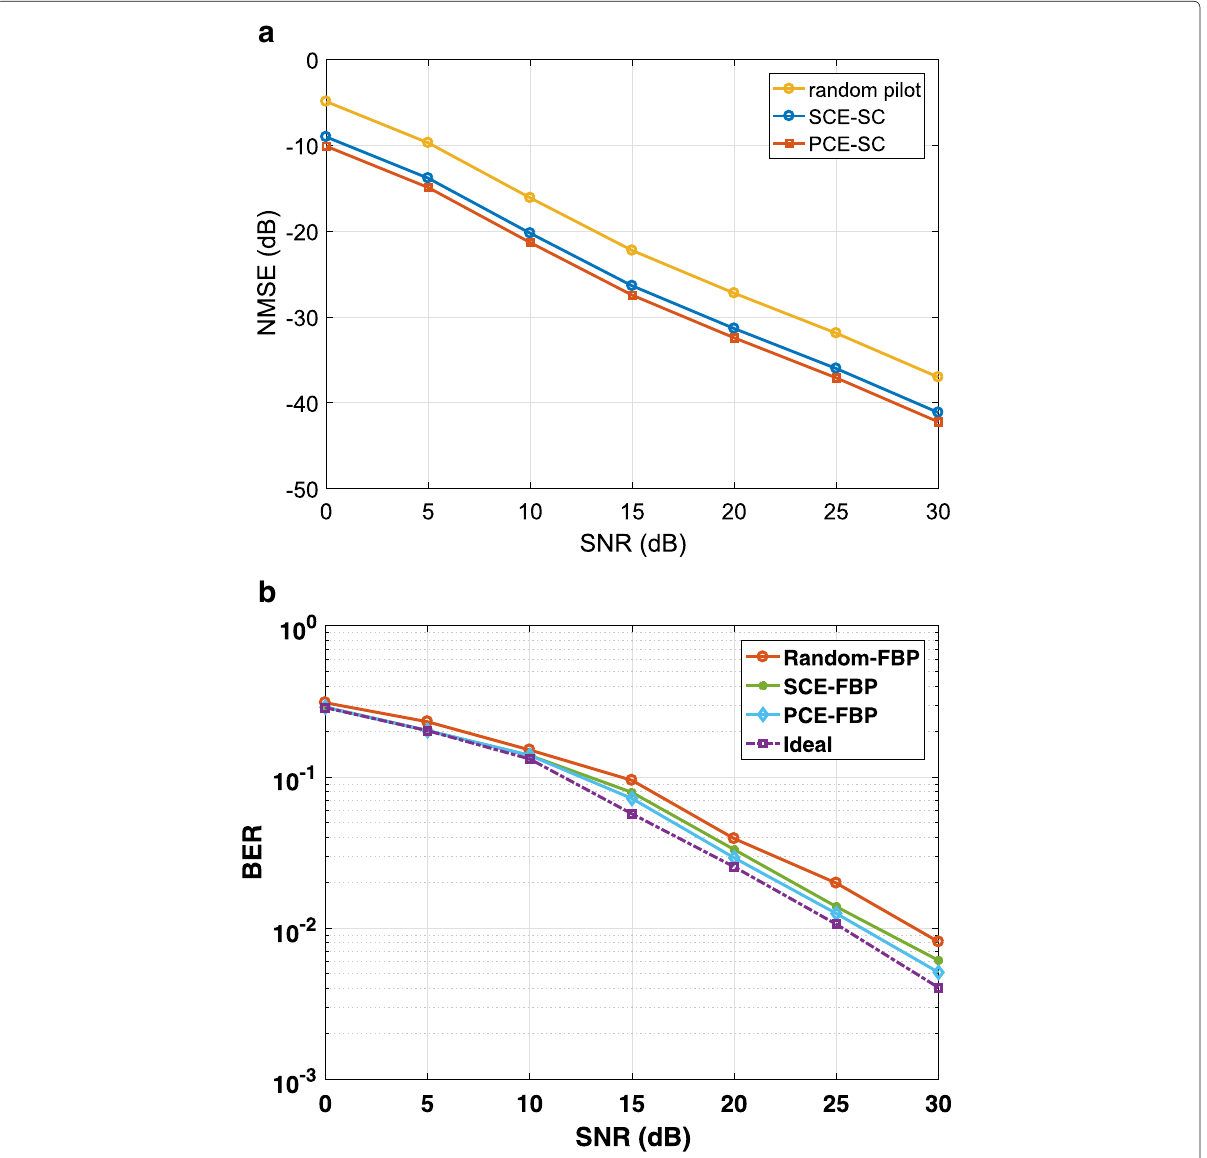
Fig. 4 Comparison of different proposed pilot allocation algorithms utilizing ( a ) NMSE and ( b ) BER performance